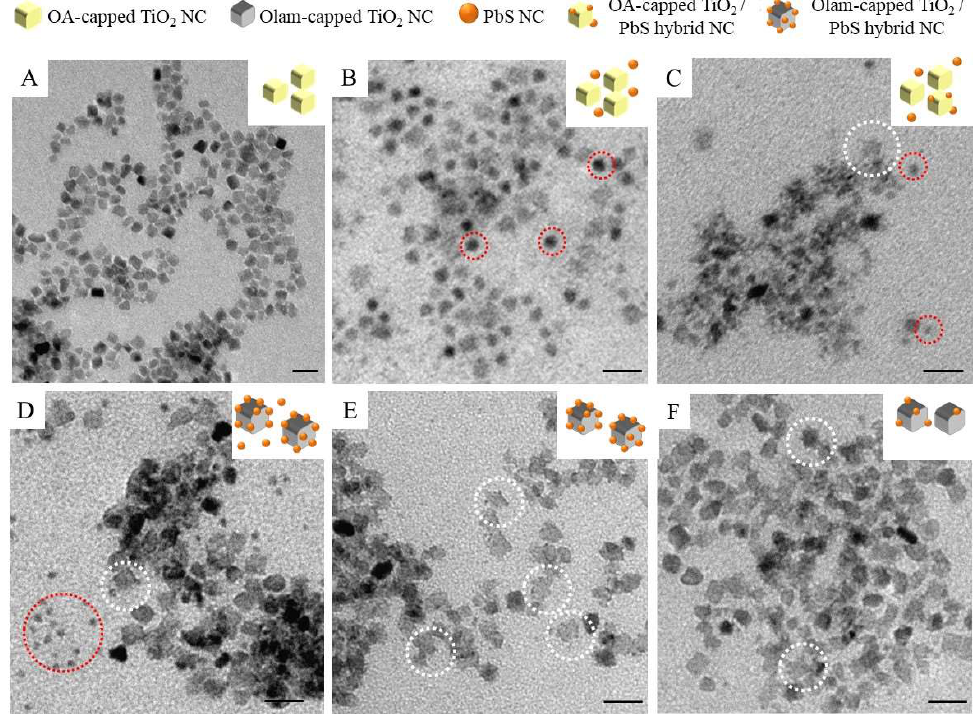
Figure 2. TEM micrographs (scale bar 20 nm) of oleic acid (OA)-capped TiO 2 NCs before ( A ) and after (B-C) injection of ( B ) [Pb 2+ ] = 0.01M, [HMDS] = 0.002 M at 120 °C and ( C ) [Pb 2+ ] = 0.005M, [HMDS] =